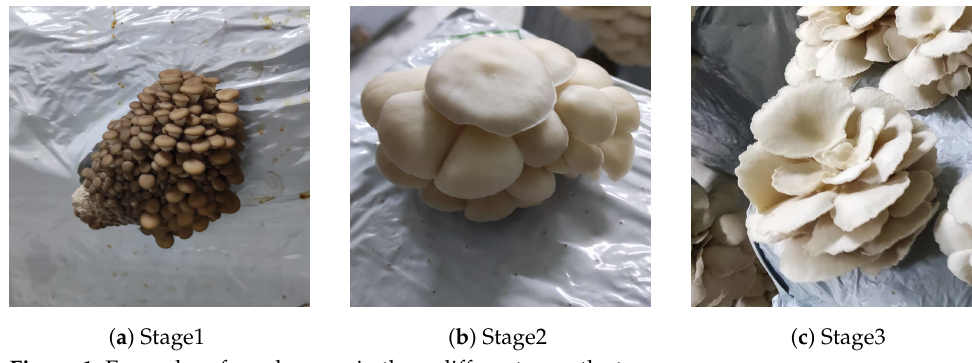
Figure 1. Examples of mushrooms in three different growth